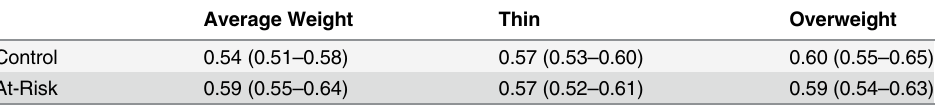
Table 2. Means and 95% confidence intervals for absolute minimum interpersonal distance from ava- tars of each body size for participants with elevated weight concerns versus control groups. Dis- tances are reported in